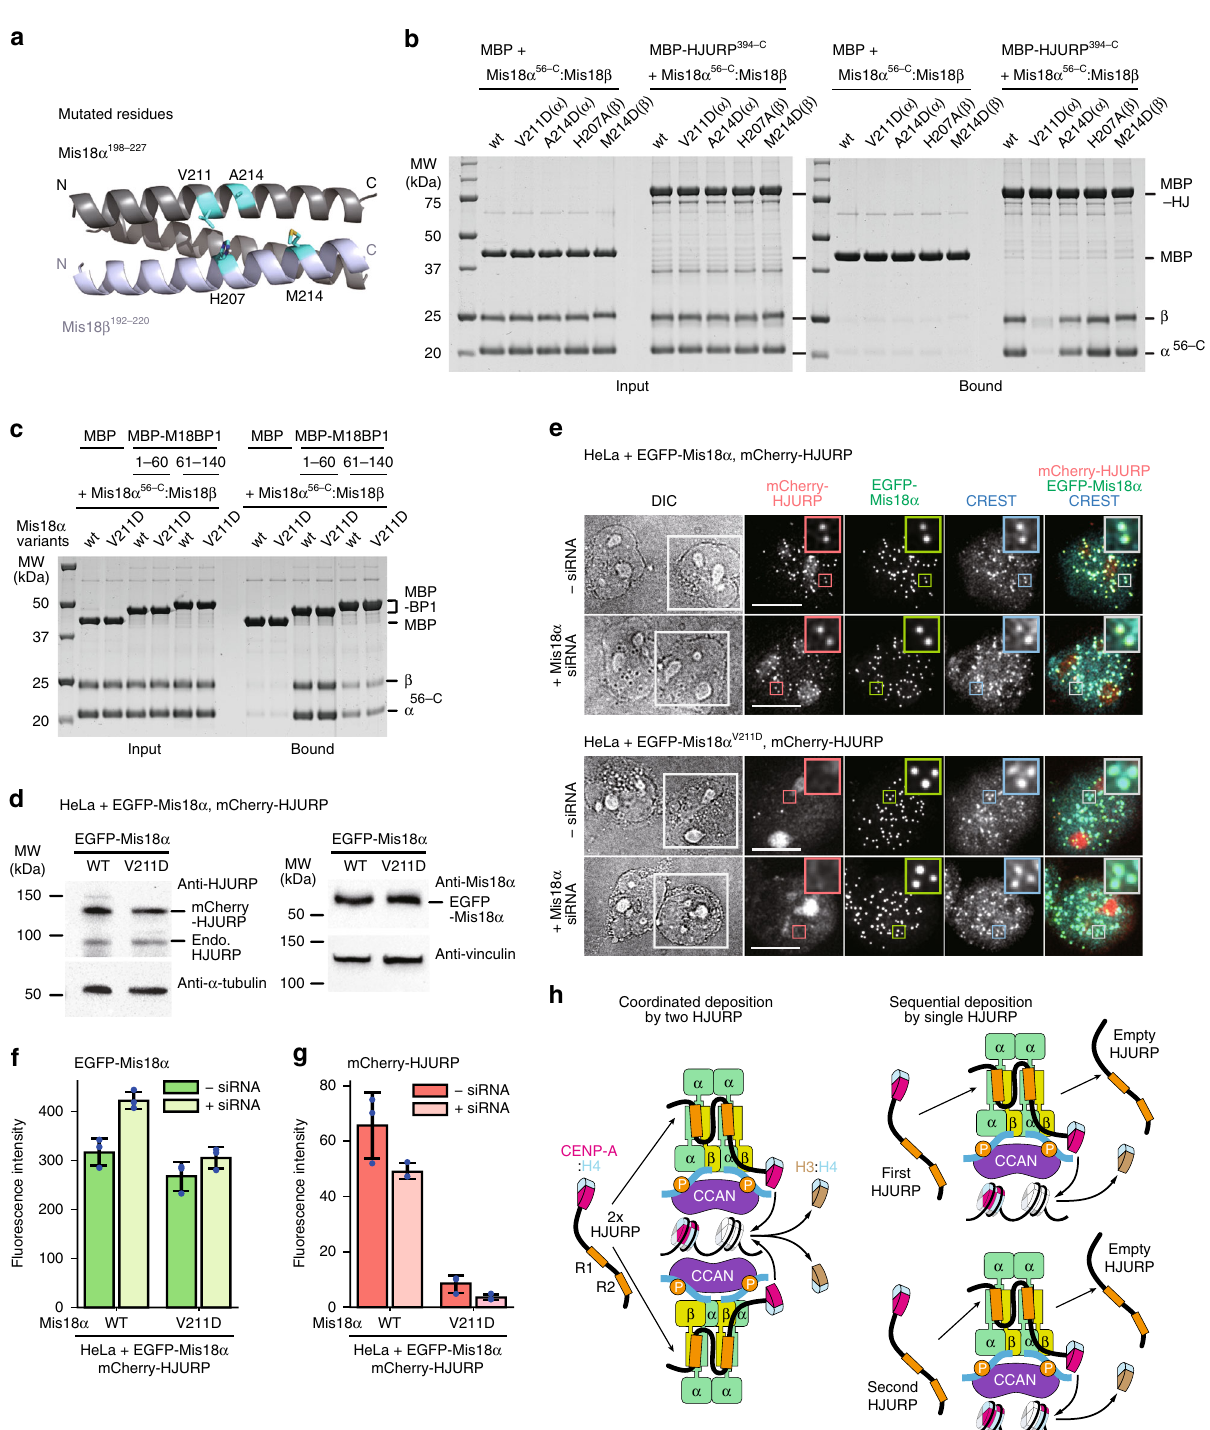
Fig. 8 Mis18 V211D is a separation-of-function mutant with impaired HJURP binding but not M18BP1 binding. a Mutated residues of Mis18 α and Mis18 β are indicated on the 3D model. b , c SDS-PAGE results of the amylose-resin pull-down assays for testing the interaction of the mutants of Mis18 α and Mis18 β with HJURP 394 – C , M18BP1 1 – 60 , and M18BP1 61 – 140 . d Western blotting analysis con fi rming transgene expression. Endo. endogenous. e Representative images showing the fl uorescence of mCherry-HJURP and EGFP-Mis18 α variants in fi xed HeLa cells treated as described in Fig. 2a but without the blocking and labeling steps of SNAP-CENP-A. Mis18 α siRNA was used instead of HJURP siRNA. White scale bars indicate 10 µ m. f , g Quanti fi cation of the centromere fl uorescence intensity of mCherry-HJURP and EGFP-Mis18 α variants. The bar graphs represent mean values from three replicate experiments (blue dots indicate the mean values from each experiment). Error bars indicate standard deviations. h Two models of HJURP recruitment to the Mis18 receptor and the deposition of CENP-A:H4 dimers. Source data are provided as a Source Data fi